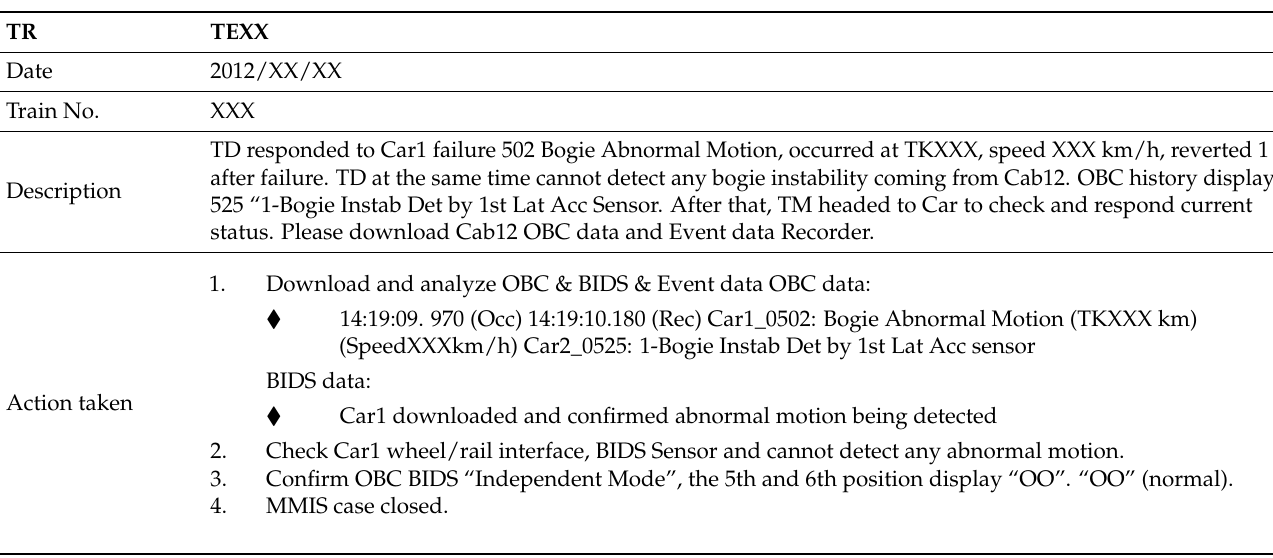
Table 2. Sample of a Trainset Failure